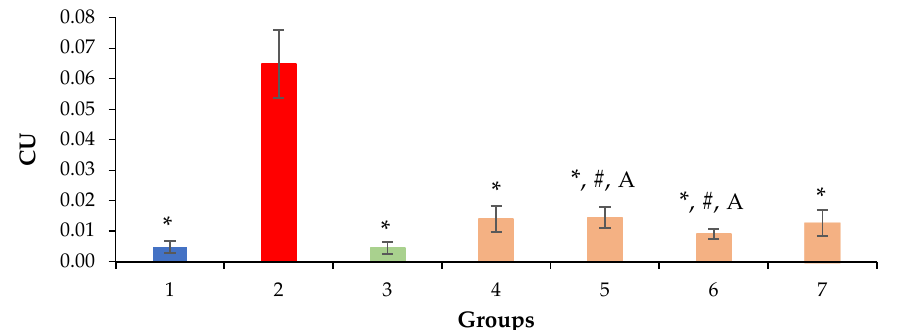
Figure 8. Volume density of liver necrosis. * p ≤ 0.05 as compared to the negative control; # p ≤ 0.05 as compared to the intact control; A p ≤ 0.05 as compared to silymarin 100 mg/kg. CU: conventional units; 1: intact control; 2: negative control; 3: positive control; 4: mice treated with QS-528 at a dose of 60 mg/kg; 5: mice treated with QS-528 at a dose of 90 mg/kg; 6: mice treated with QS-528 at a dose of 120 mg/kg; 7: mice treated with QS-528 at a dose of 150 mg/kg.